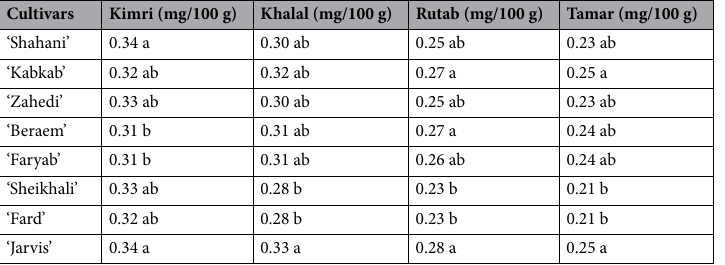
Table 5. Chlorophyll b content of ‘Piarom’ date fruit in kimri, khalal, rutab and tamar stages after pollination with eight pollinating cultivars. Different letters within columns indicate significant differences according to Duncan’s multiple range test (p < 0.05).